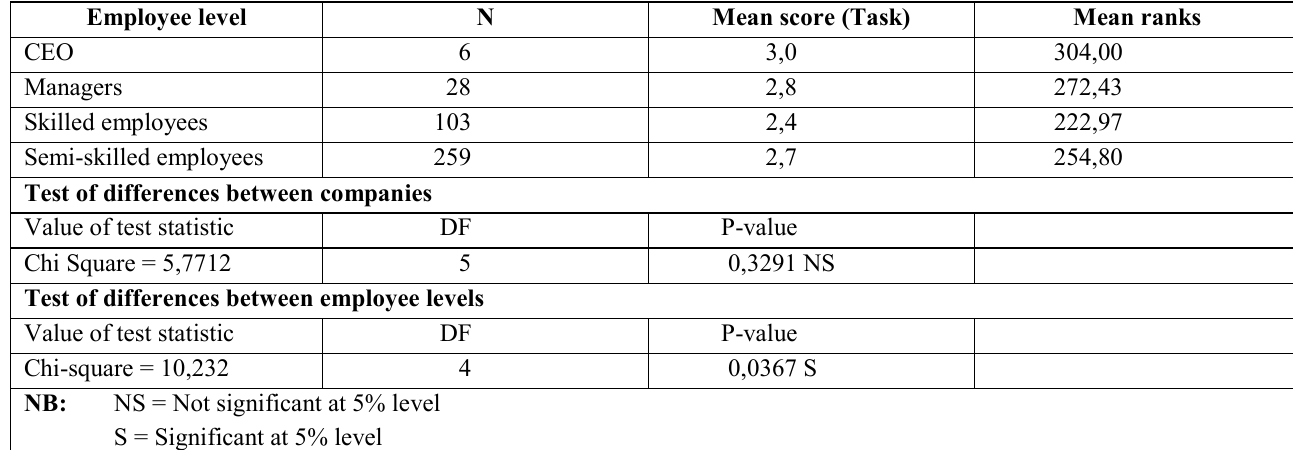
Table 2: Variable: Task/people orientation: means by employee level Employee level